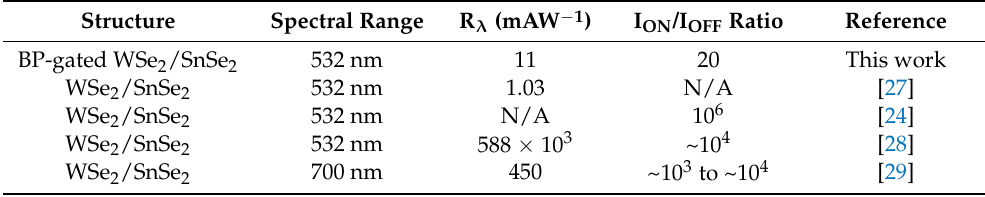
Table 1. Comparison of figures-of-merit for photodetectors based on WSe 2 / SnSe 2 heterojunction.